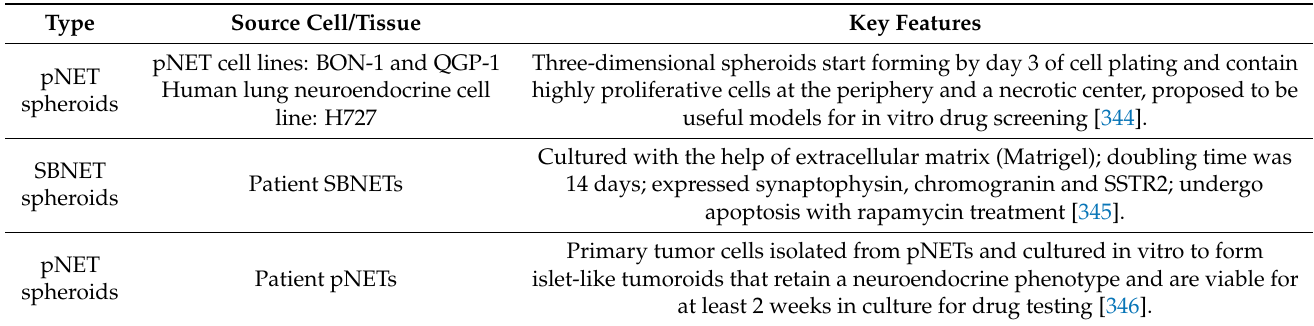
Table 12. In vitro models: 3D cell